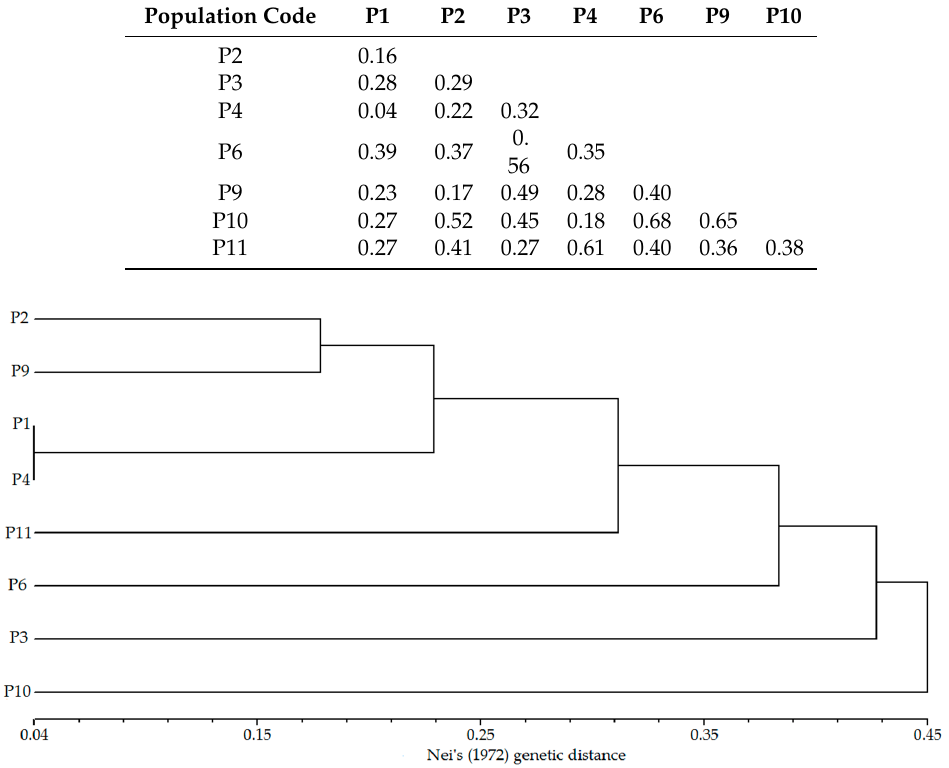
Figure 4. Genetic divergence among eight Erythrophleum fordii populations based on UPGMA clustering analysis.